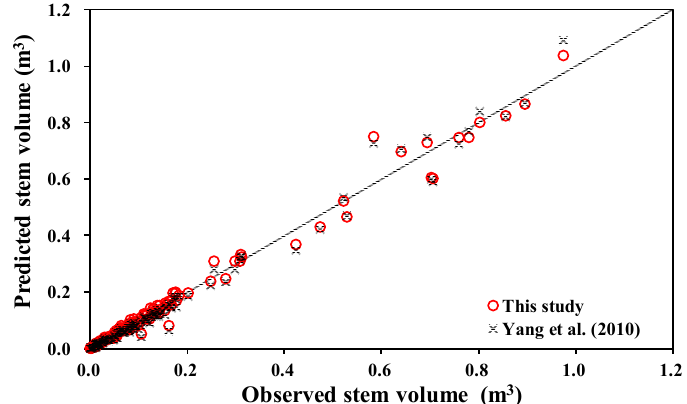
Figure 7. Comparison between our two-predictors stem volume model (M2) with the stem volume equation based on D and H developed by Yang et al. [50].